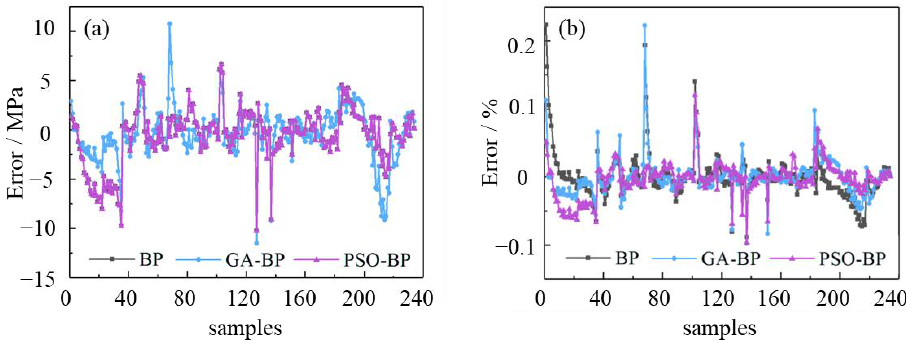
Figure 25. The prediction error and error ratio of neural network model (the data from [74]), ( a ) prediction error; ( b ) prediction error ratio.